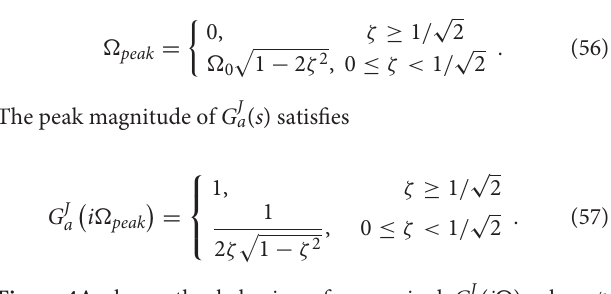
FIGURE 4 | Dependence of filter properties on parameters. (A) Magnitude of a typical second order filter G J a ( s ) from Equation (55) for (cid:127) 0 various ζ , as labeled. (B) Response of G J a ( s ) to an impulse input signal for various ζ . (C) Magnitude of the total T J ba H J ba ( s ) τ − 1 p ) for various τ p . (D) Response of T J ba when the input signal is an impulse function for various τ p . ( s = +